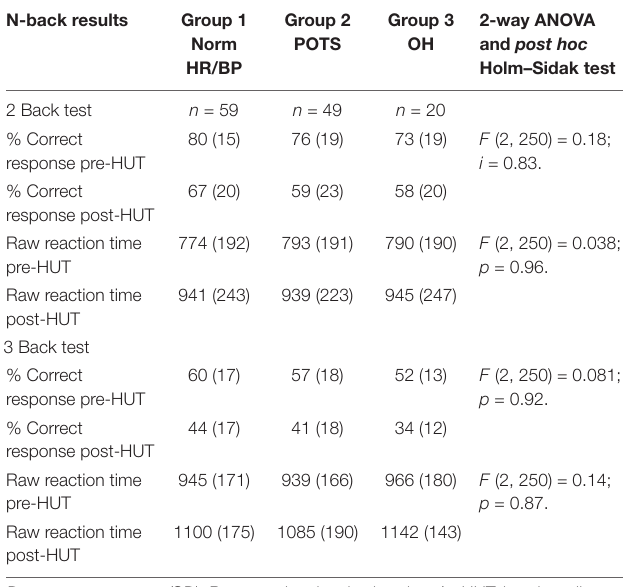
Data represent mean (SD). Raw reaction time is given in m/s. HUT: head-up tilt test; Norm HR/BP: normal heart rate and blood pressure response of the head-up tilt test; POTS: postural orthostatic tachycardia